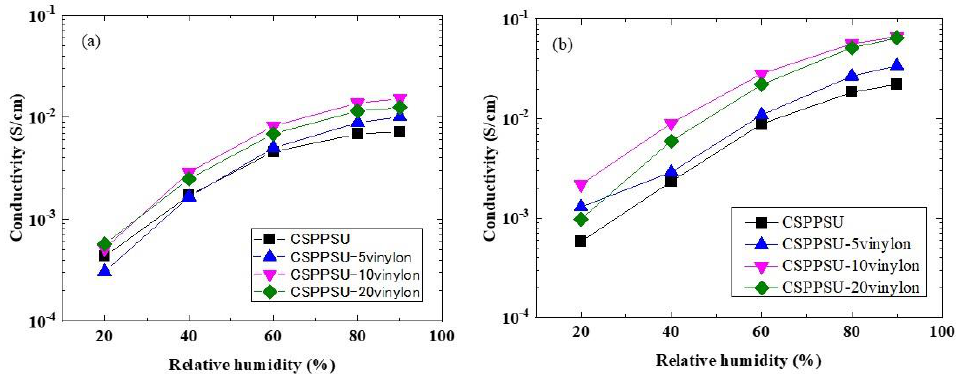
Figure 5. Proton conductivities of the CSPPSU-vinylon membranes vs. the relative humidity at ( a ) 40 and ( b ) 120 °C. Table 5. Physicochemical and conductivity properties of the CSPPSU-vinylon membranes.